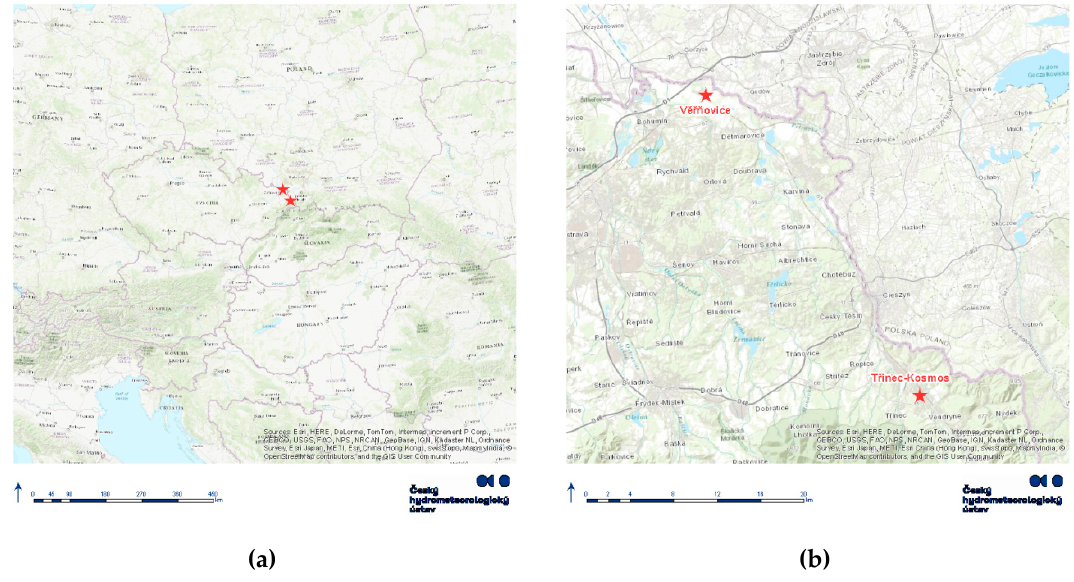
Figure 1. The assessed site location: ( a ) The location within Central Europe; ( b ) The location within the Czech-Polish border region.